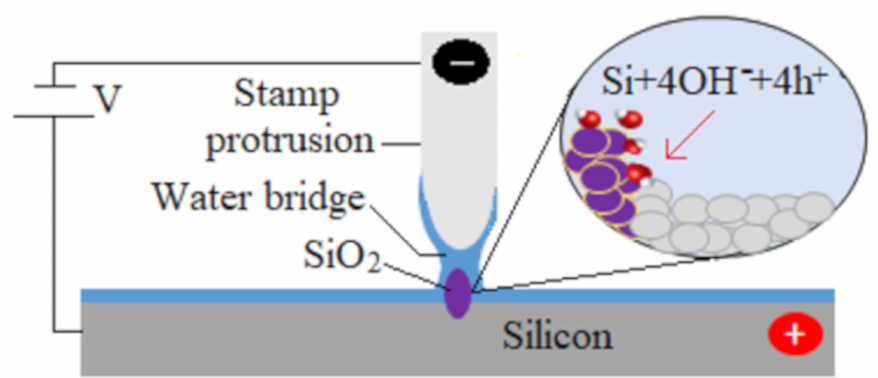
Figure 1. Schematic diagram of the nanoelectrode nanolithography (NEL) process on a silicon